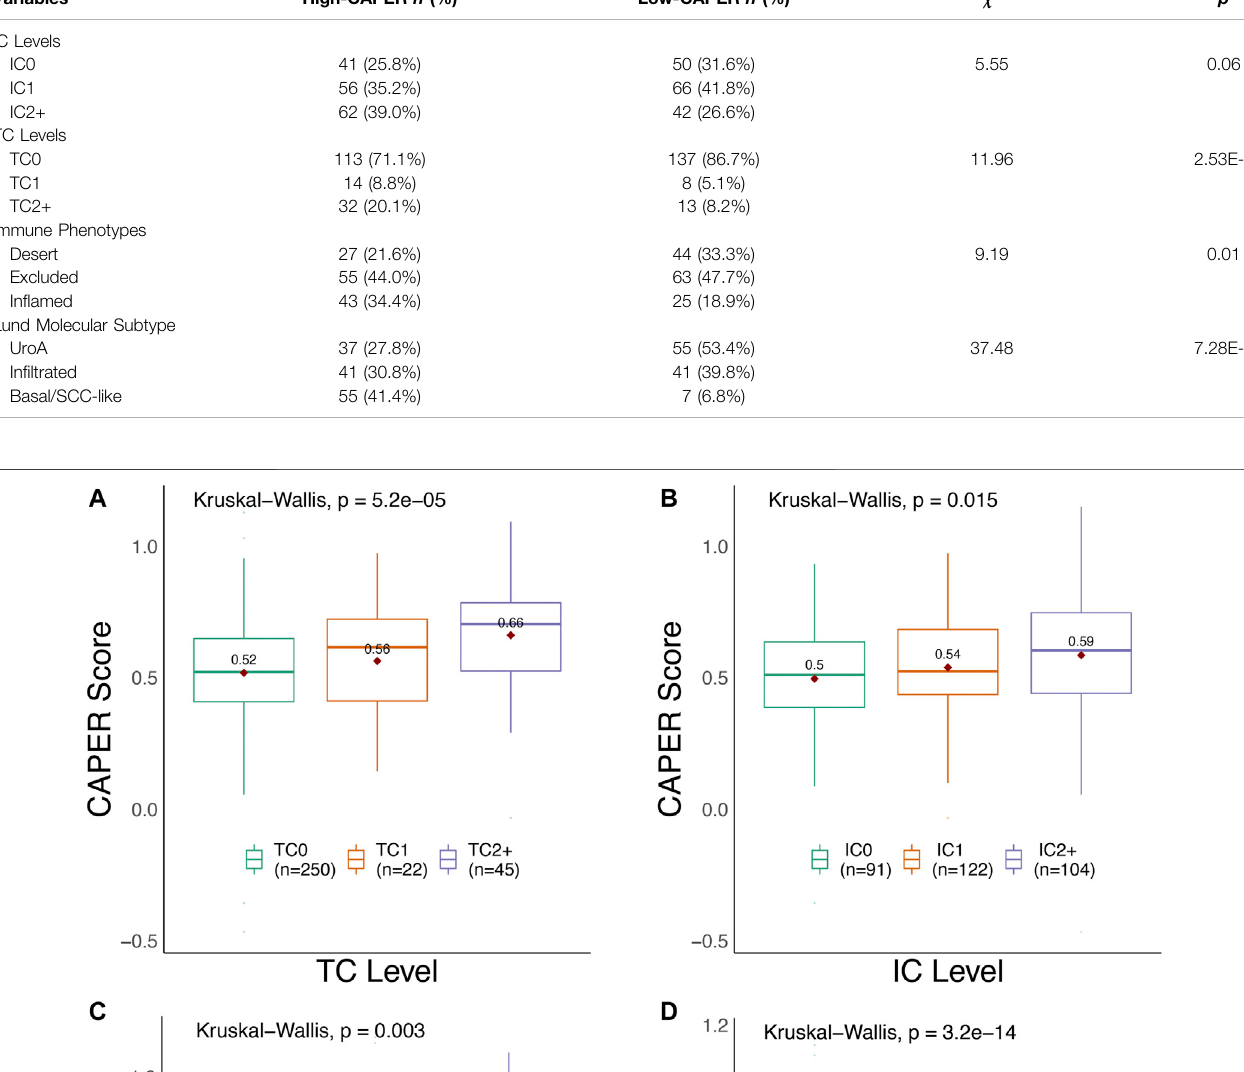
Frontiers in Genetics |